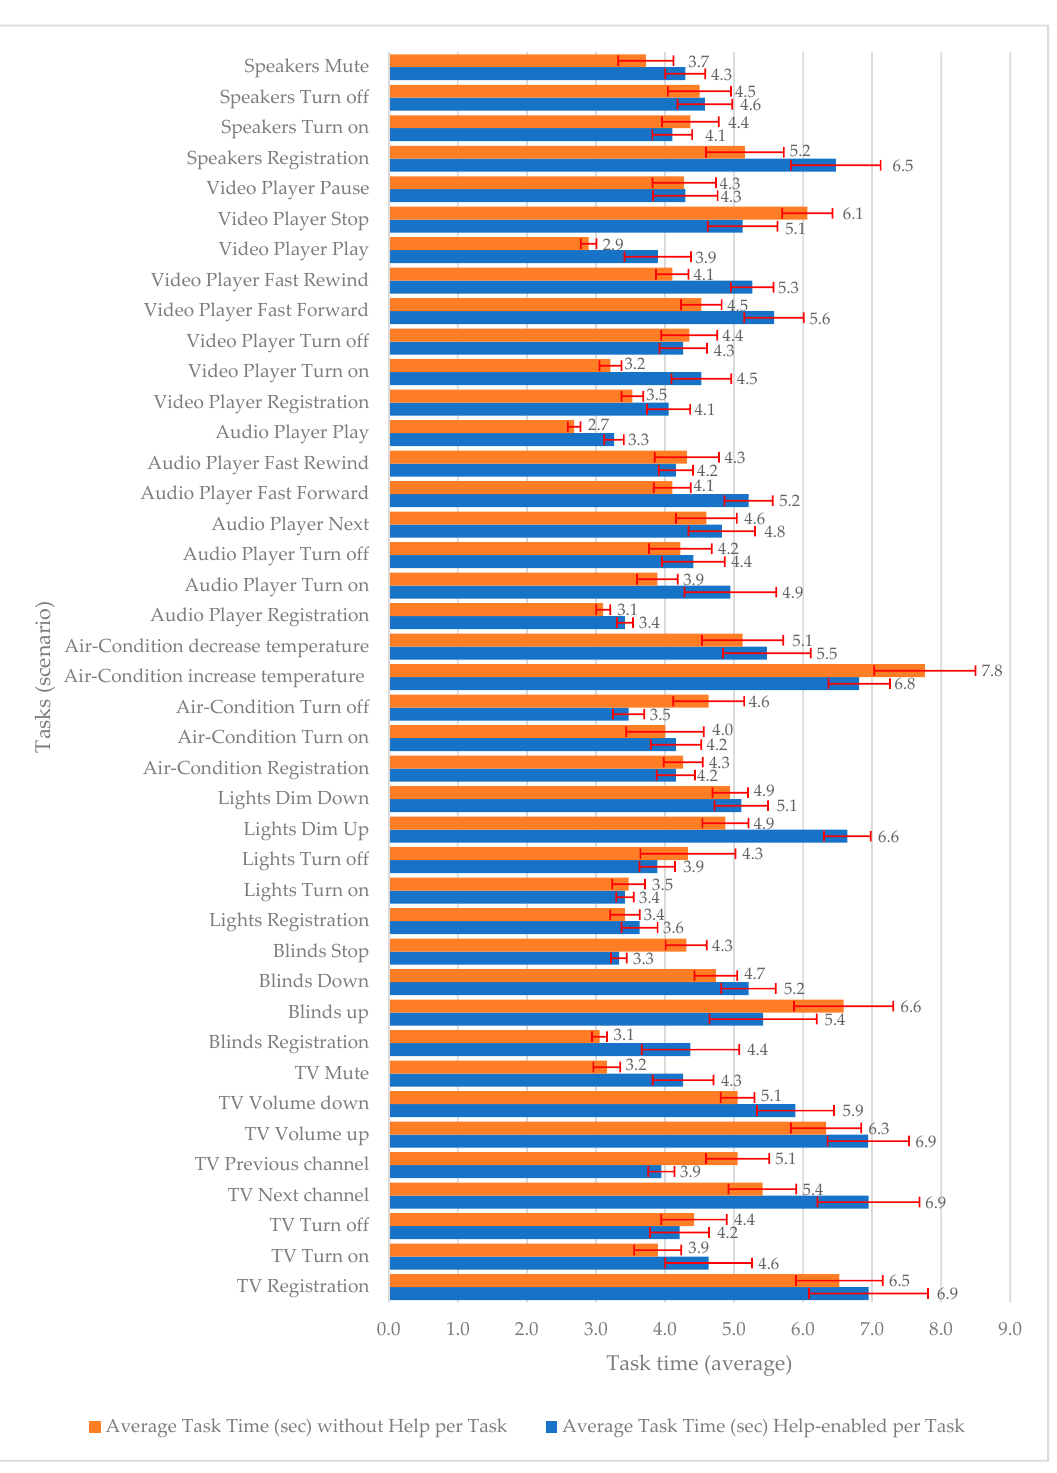
Figure 5. Task completion time.